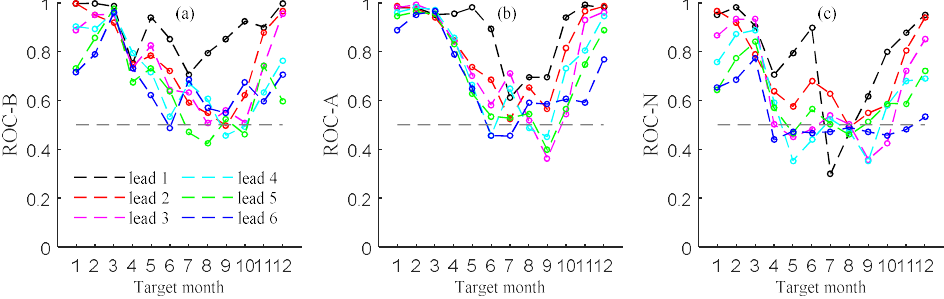
Figure 4. Variation of ROC areas for ( a ) below-normal, ( b ) above-normal, and ( c ) near-normal with the target month for six lead times for the Yellow River. Table 2. Mean skill metrics over all target months and lead times for the study